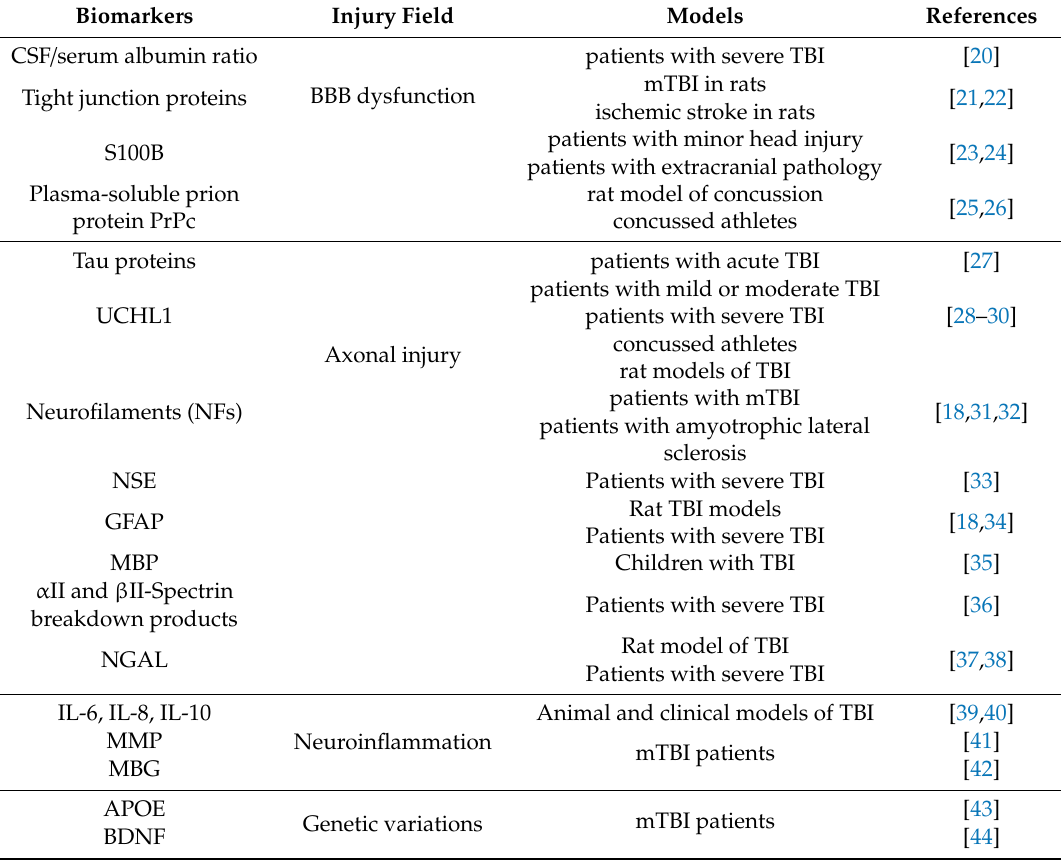
Table 2. Biomarkers in